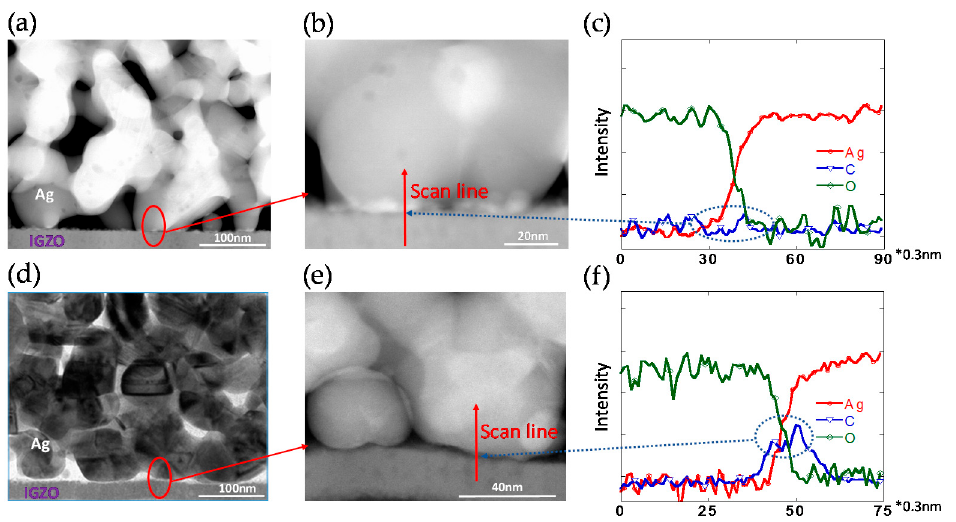
Figure 5. Comparision of Ag/a-IGZO interfaces for silver salt and nanoparticles inks. ( a ) TEM image of the silver/a-IGZO structure for silver salt ink. ( b , c ) Respectively show the amplified area and the EELS measurement of Ag, C, and O along marked scan line. ( d – f ) TEM images and the ELLS measurement for the nanoparticles ink.